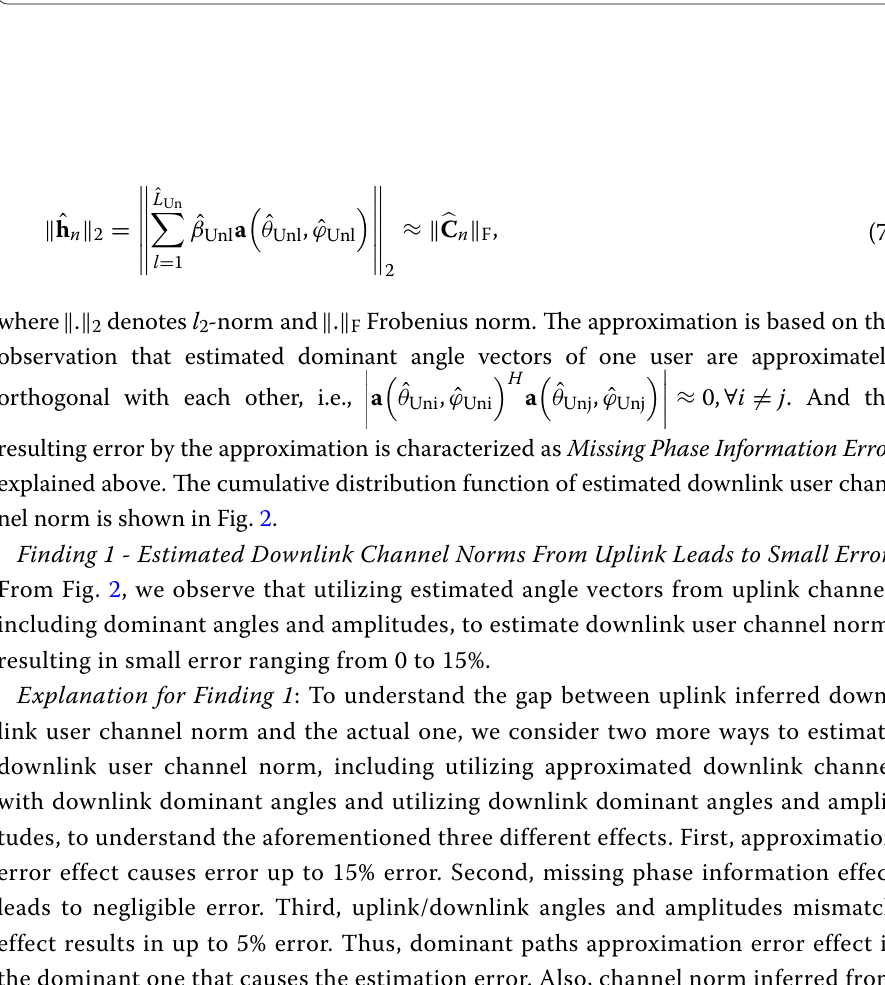
Fig. 2 The cumulative distribution function of estimated downlink channel norm for all measured channels. This includes estimations by utilizing full downlink channel (labeled as full-channel), approximated downlink channel with downlink dominant angles (labeled as dom-path-channel), downlink dominant angles and amplitudes (labeled as dom-angle-amp), and estimated downlink dominant angles and amplitudes from uplink channel (labeled as UL-dom-angle-amp),